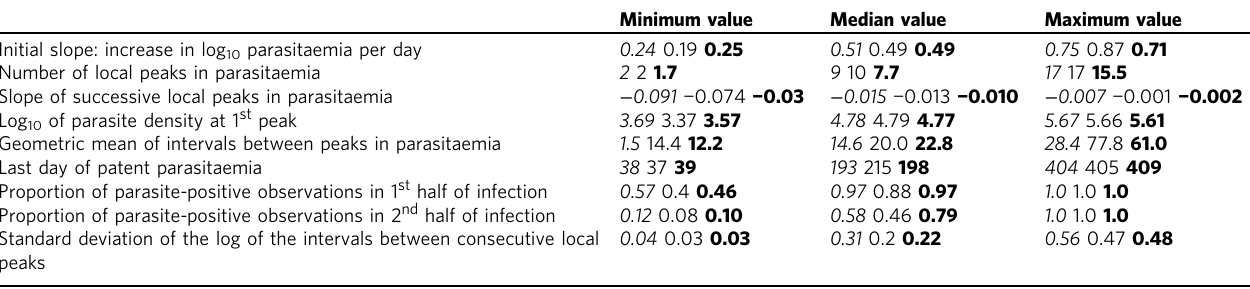
Herewedisplaythevaluesoftheninesummarystatisticsdescribingdynamicsofuntreatedinfectionsinthemalariatherapydatausedto fi tthemodel,asinref. 30 .Thecentralvaluesarethedata,values on the left (italics) are best- fi t values from the model by Johnston et al., and values on the right (bold) are the best- fi t values for our model (see Supplementary Methods for details and a description of the summary statistics). All quantities are based on parasitaemia detectable via microscopy. A local peak in the parasitaemia was de fi ned as a parasite density greater than the three previous model observations, and greater than or equal to the next three observations. The fi rst and second halves of the infection are de fi ned via the fi rst and last days that the patient was parasite positive by